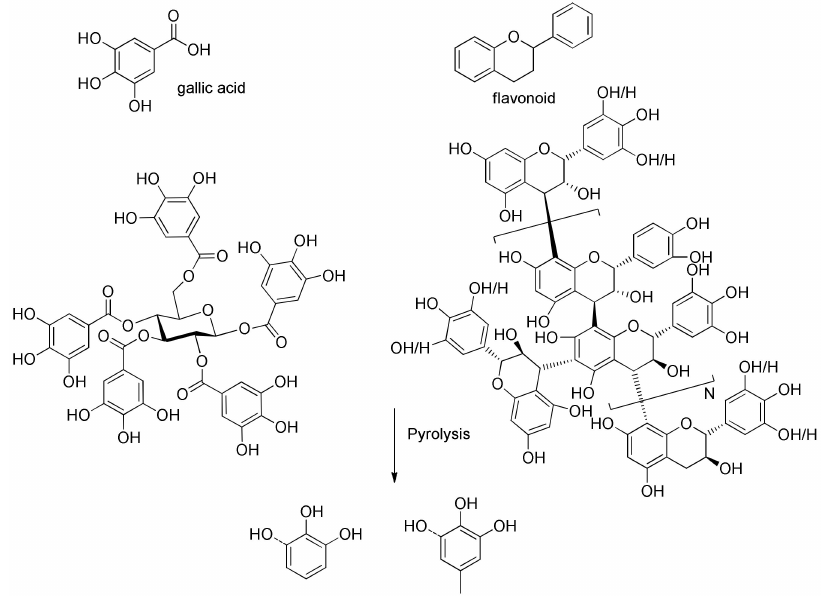
Figure 1. Model structures of tannin, and major pyrolysis products from